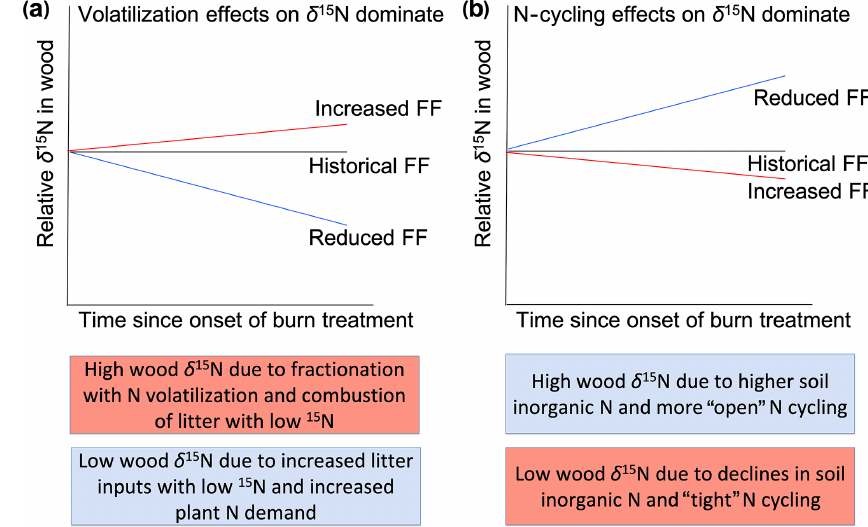
Figure 1. Hypothesized effects of fire experimentation on wood δ 15 N values relative to the historical fire frequency (FF). Increased FF would lead to higher relative wood δ 15 N values if combustion and isotopic fractionation with N volatilization dominate (a) . In contrast, increased FF would lead to lower relative wood δ 15 N values if N-cycling effects such as reduced N stocks and non-fire N losses dominate the trajectory of wood δ 15 N values (b) . Colored boxes indicate potential contrasting effects of fire frequency on wood δ 15 N values. Pink and blue boxes indicate processes resulting from higher and lower FF,